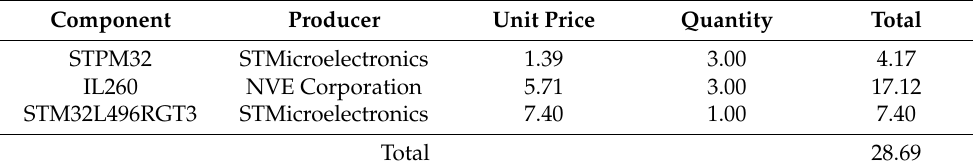
Table 6. Main components in the setup of Figure 41.